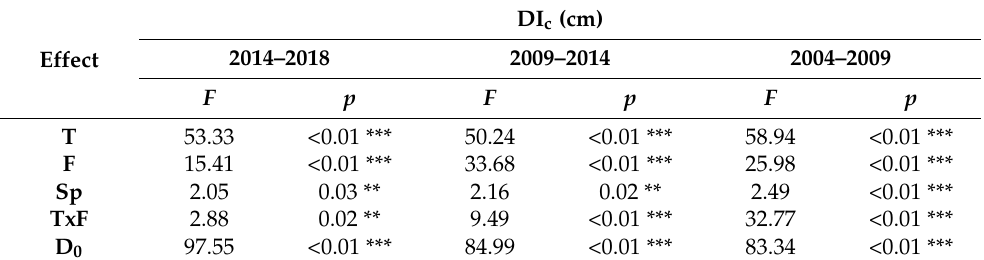
Table 5. Analysis of covariance results for diameter increment. Results include F -statistic ( F ) and p -values ( p ) for the first three five-year increment periods (2004–2009, 2009–2014, and 2014–2018) at the plot level. Initial diameters D 0 (diameters in 2004, 2009 and 2014) were used as covariates.